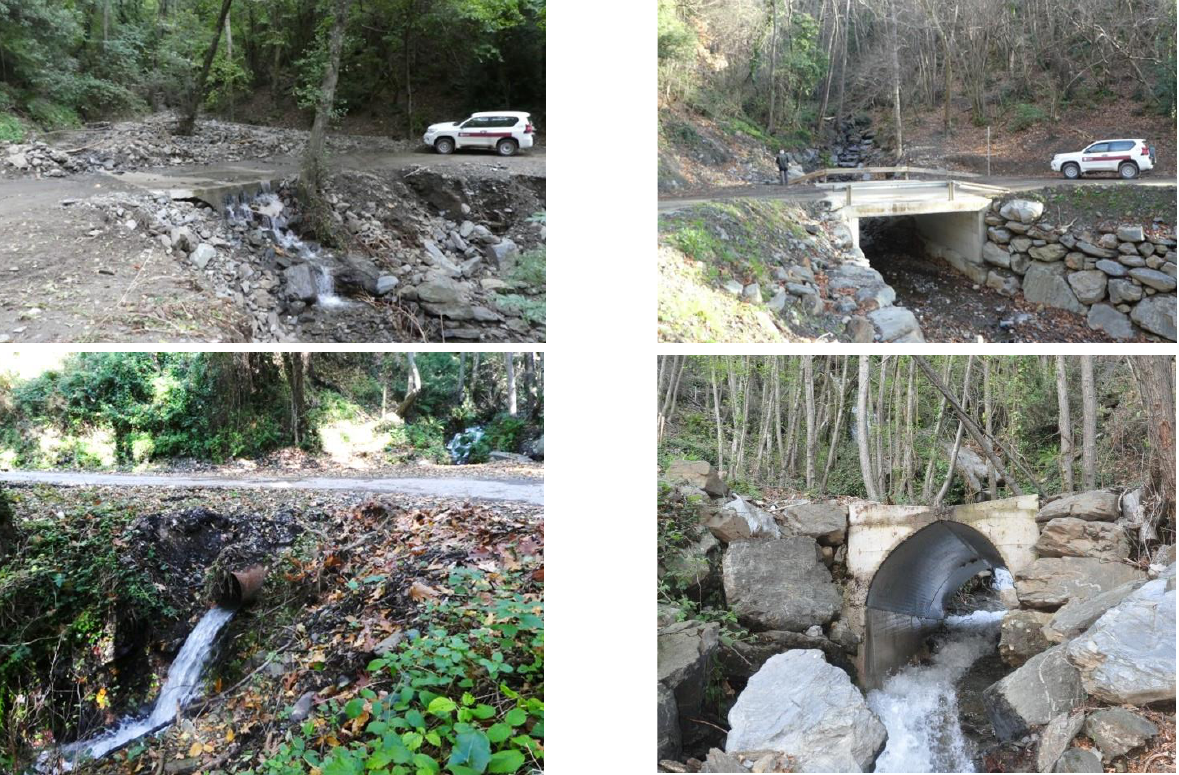
Figure 14. Modified bridges to recover the natural stream bed and to allow the displacement of aquatic fauna along them. Left images: before recovering structure. Right images: the same locality after recovering structure.